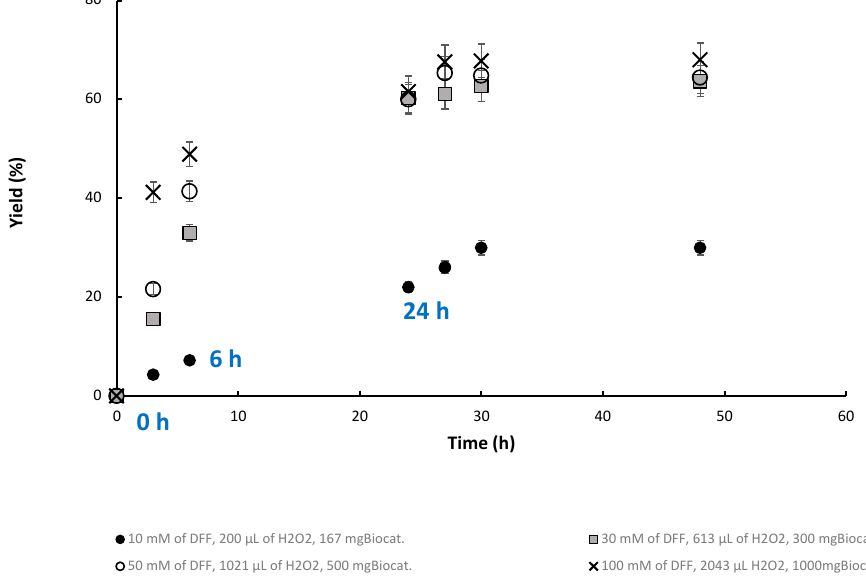
Figure 3. Chemoenzymatic synthesis of FDCA with stepwise addition of H 2 O 2 . Operational condi- tions: 10 mL of reaction volume and 40 ◦ C. The H 2 O 2 addition was divided into three portions along the reaction: at the beginning, 6 h, and at 24 h.